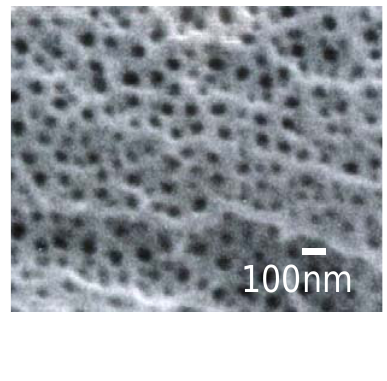
Figure 1. (a) Nano-open structure of anodized aluminum surface. Surface image was taken using a scanning electron microscope. (b) Schematic description of anodized aluminum pressure sensitive paint